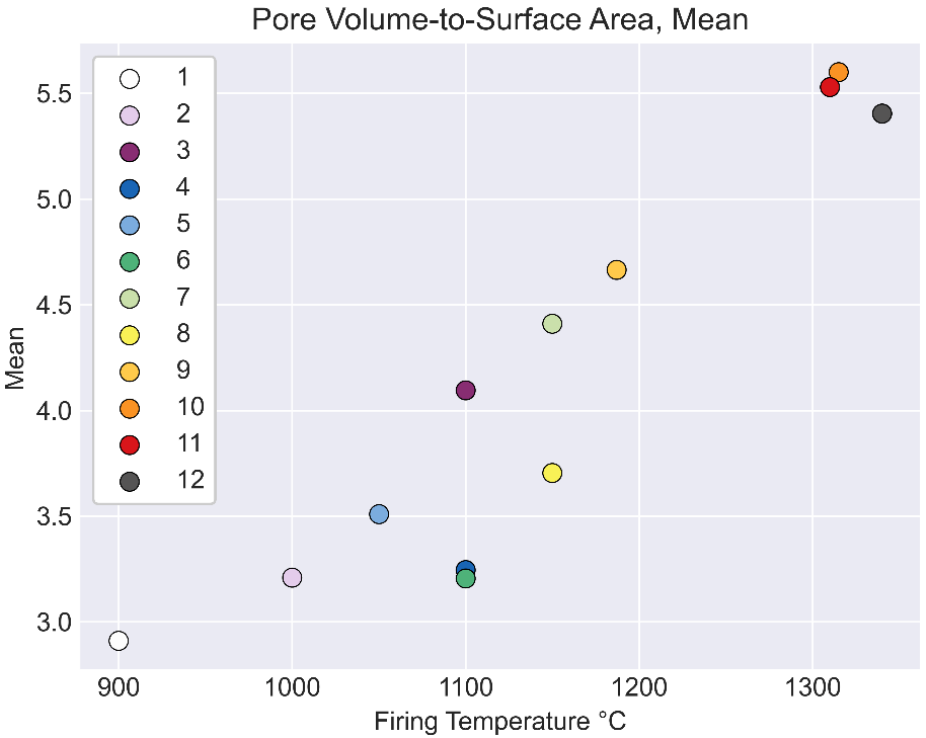
Figure 9. Pore volume-to-surface area increases with firing temperature, indicating more spherical pores at the higher temperatures. Points are mean of 2.